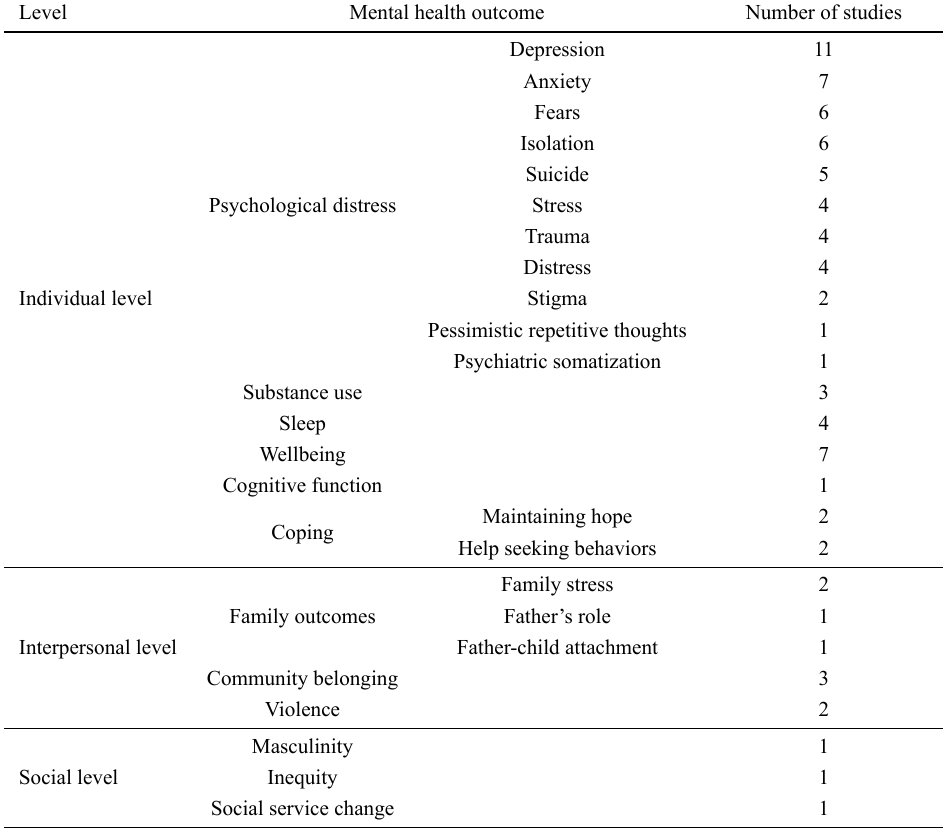
Table 2. Numbers of studies about Men’s mental health